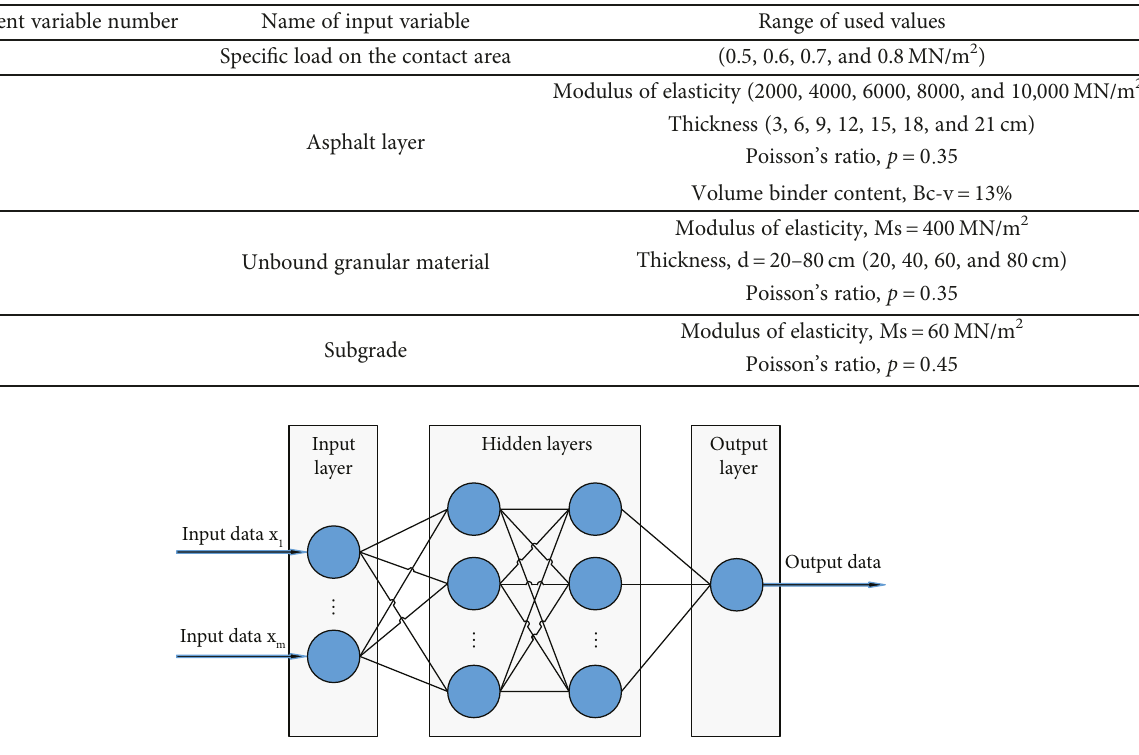
Figure 4: Con fi guration of the selected arti fi cial neural